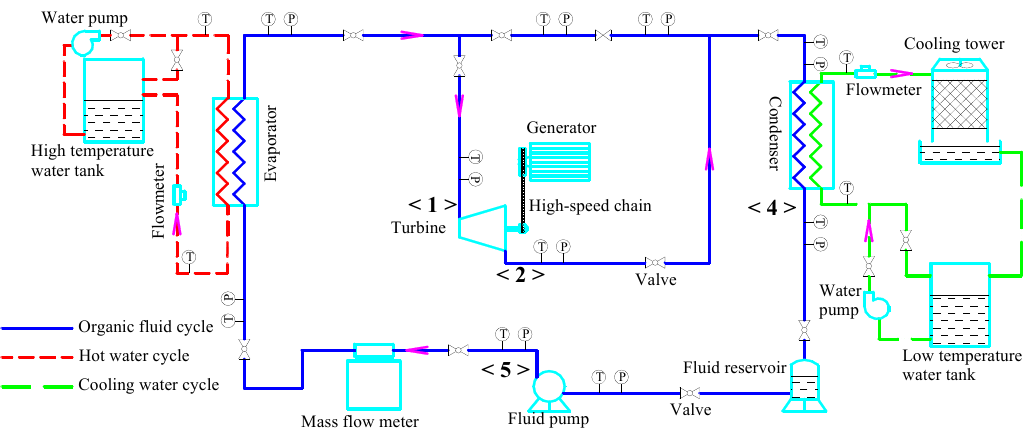
Figure 2. Flow chart of the ORC experimental system.